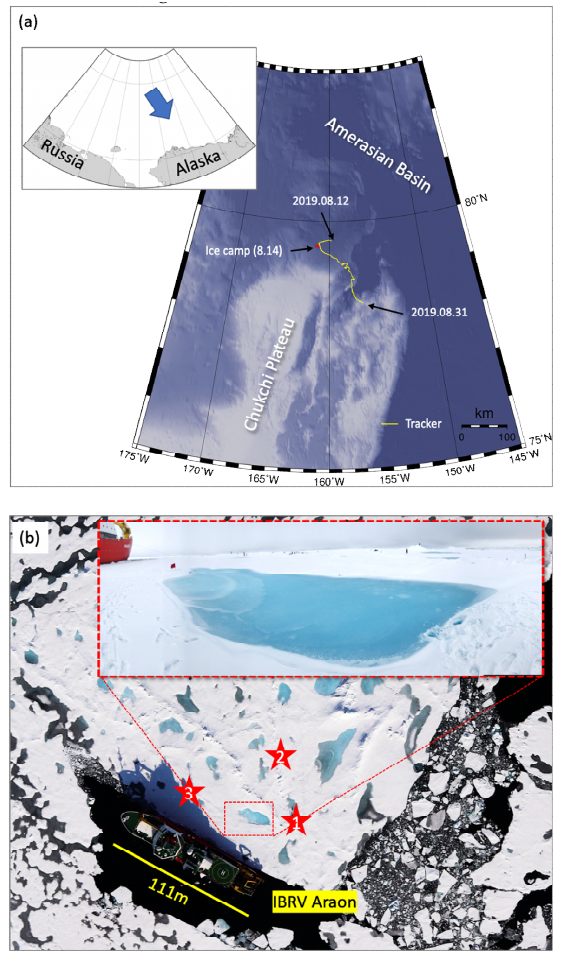
Figure 1. (a) Sea ice field campaign (ice camp) was carried on a large ice floe drifting in the marginal ice zone in the western Beaufort Sea in August 2019. Location of the ice camp on 12 August, 2019, is denoted as a red dot, while the drift of the ice floe is in yellow. (b) Surface of the ice floe, captured on a helicopter, contained hummocks and melt-ponds, which were frozen at the time of the campaign. (inlet). Red stars indicate the locations of ice coring sites. The length of ice breaker research vessel (IBRV) Araon is inserted for